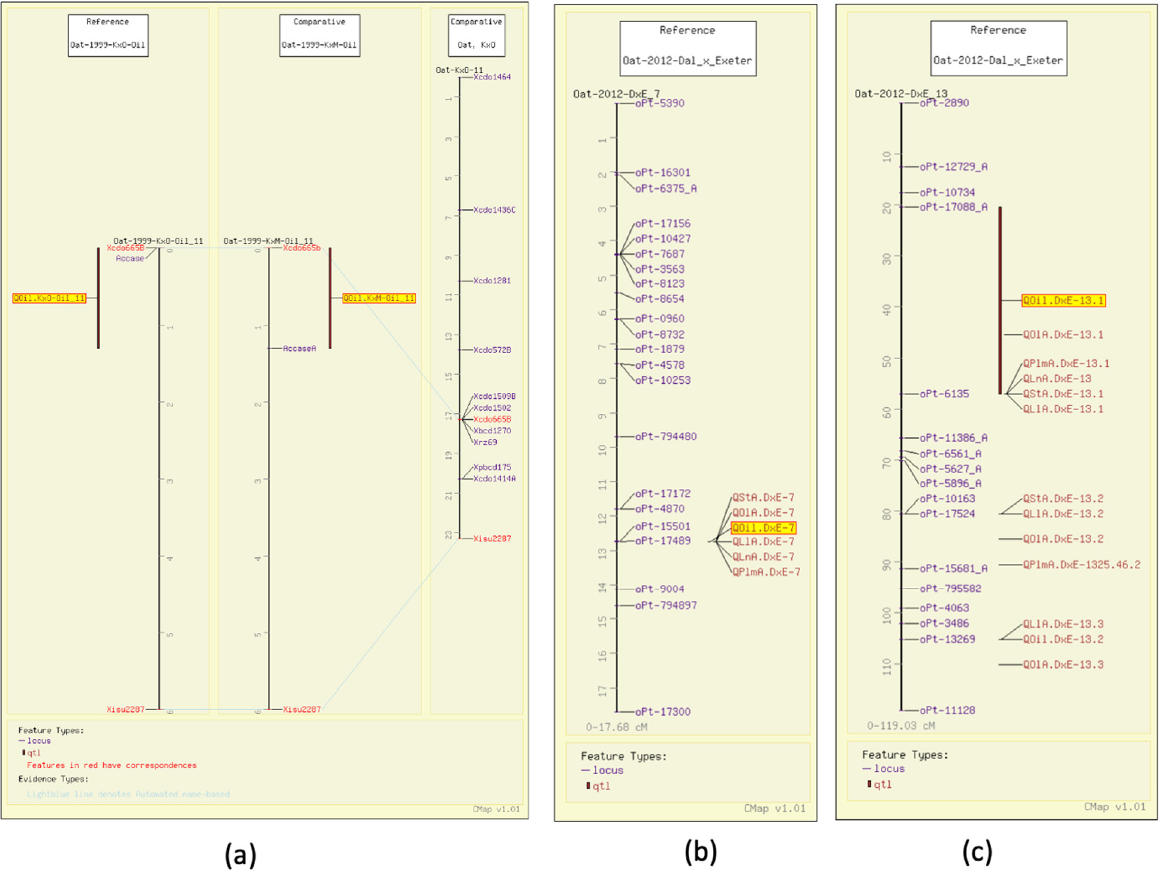
Figure 4. Groat oil content QTL illustrated on the CMap map viewing/comparative mapping tool. ( a ) Total groat oil content (highlighted) in Kanota x Marion and Kanota x Ogle populations is linked to ACCase. By aligning a consensus map published later, the region around the gene of interest can be populated with additional markers. ( b , c ) Total groat oil QTL (highlighted) mapping with the QTL for content of the five individual fatty acids.